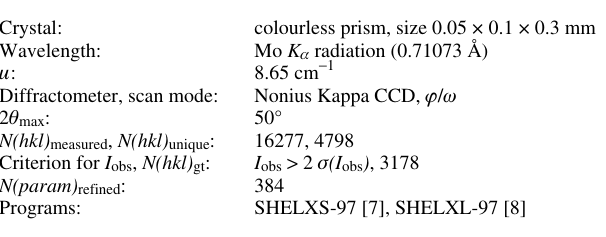
Table 1. Data collection and handling.